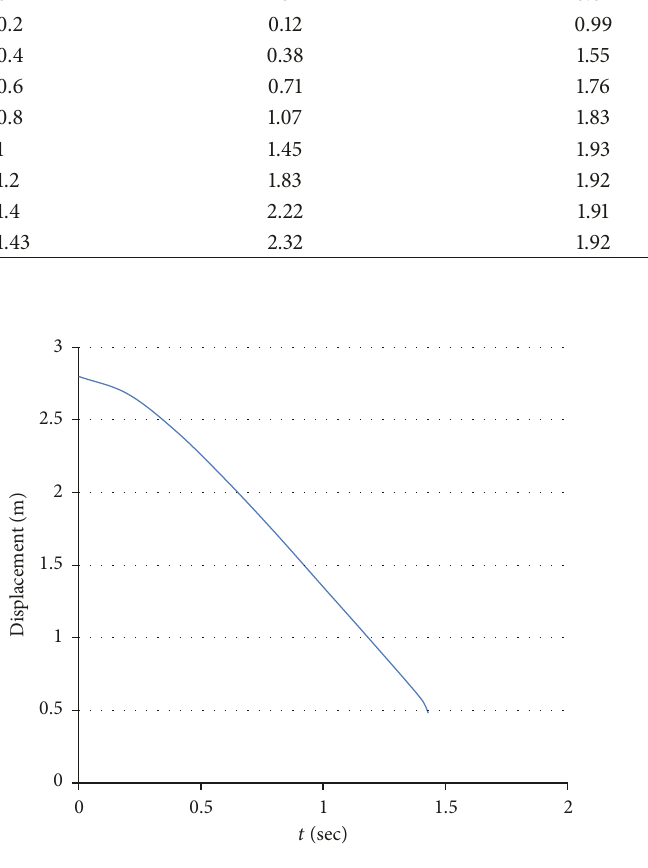
Figure 4: Displacement time history of the control rod.